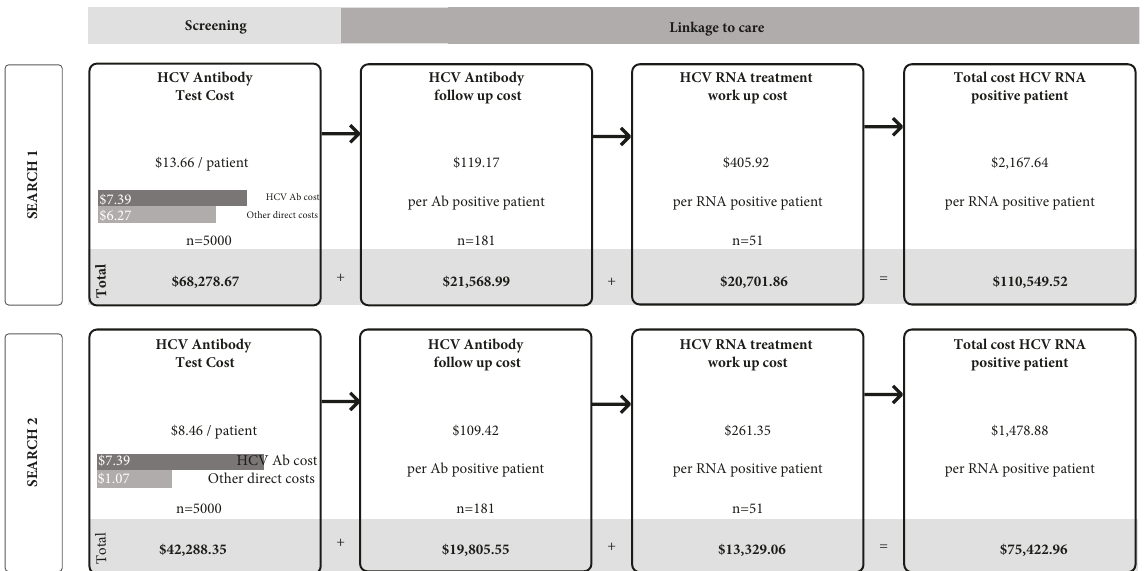
Figure 2: Costs of HCV screening in SEARCH 1 compared to costs modelled with SEARCH 2 program